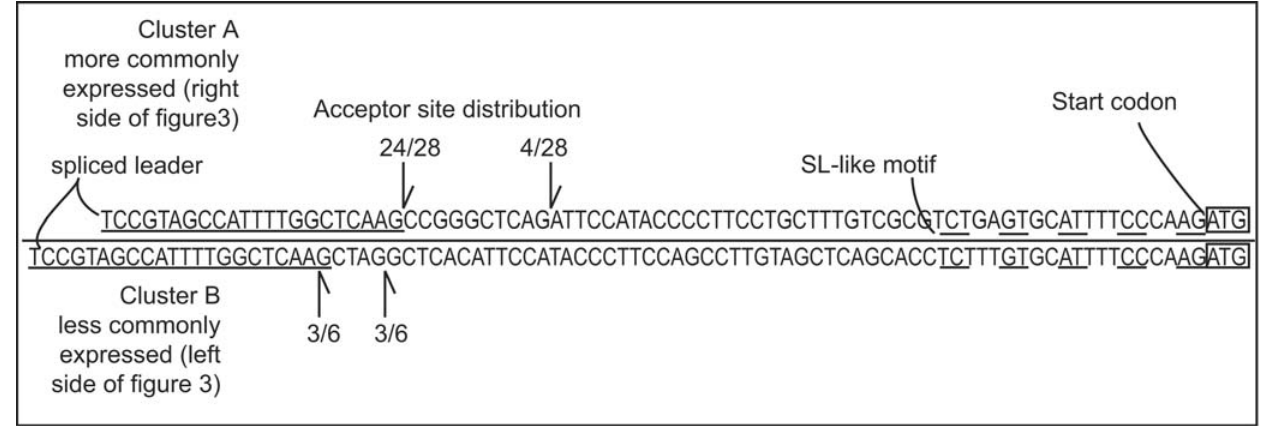
Figure 7. Actin cDNA 5 9 UTRs showing trans -splice acceptor sites. The 5 9 UTRs for the two gene clusters, one above the line and the other below the line, showing the different inferred trans -splice acceptor sites. The top sequence represents the more commonly expressed cluster (right side of tree in figure 3) and the lower sequence is rarely expressed (left side of tree in figure 3). Numbers indicate frequency of the splicing pattern in the 34 sequenced cDNAs. The trans -spliced leader sequence is underlined, a spliced leader like motif is also underlined (dashed line) just before the start codon (boxed).